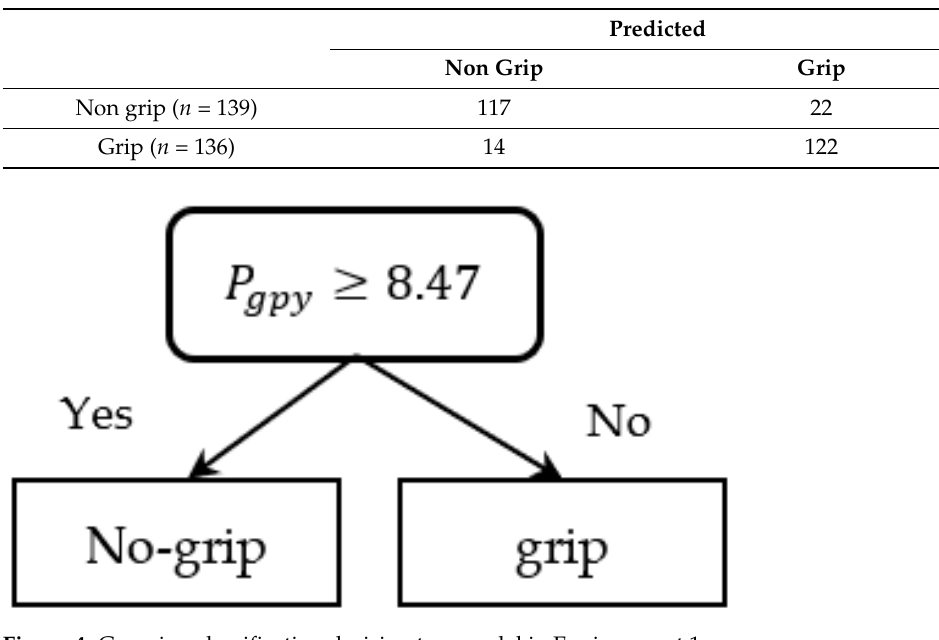
Figure 4. Grasping classification decision tree model in Environment 1.